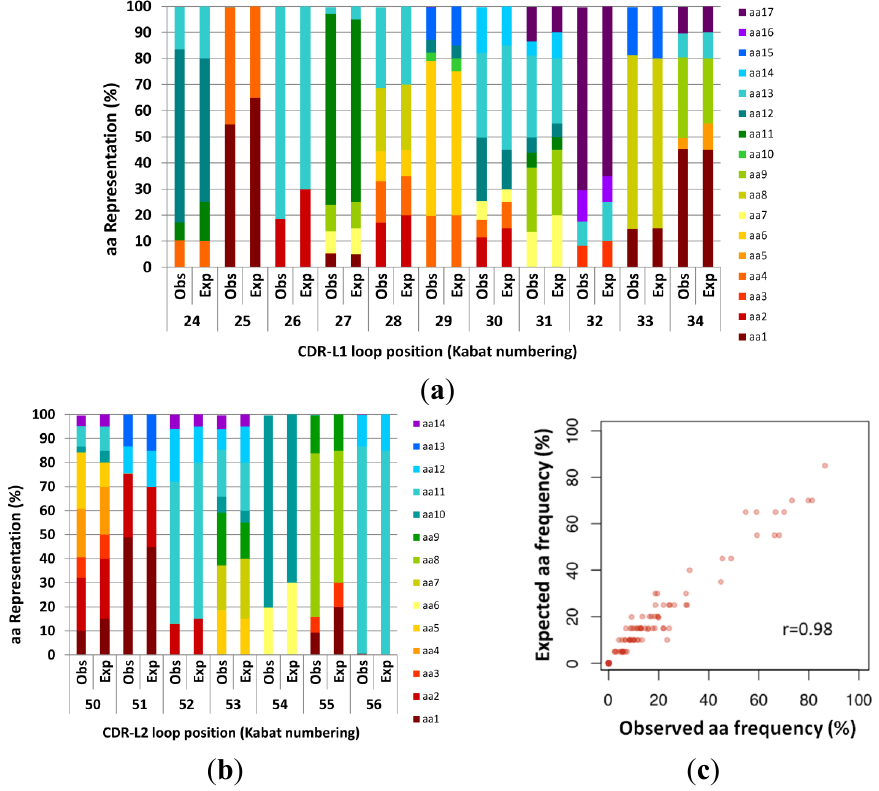
Figure 2. Expected (Exp) versus observed (Obs) amino acid frequencies in complementarity determining regions (CDR) fragment libraries created using manual hexamer